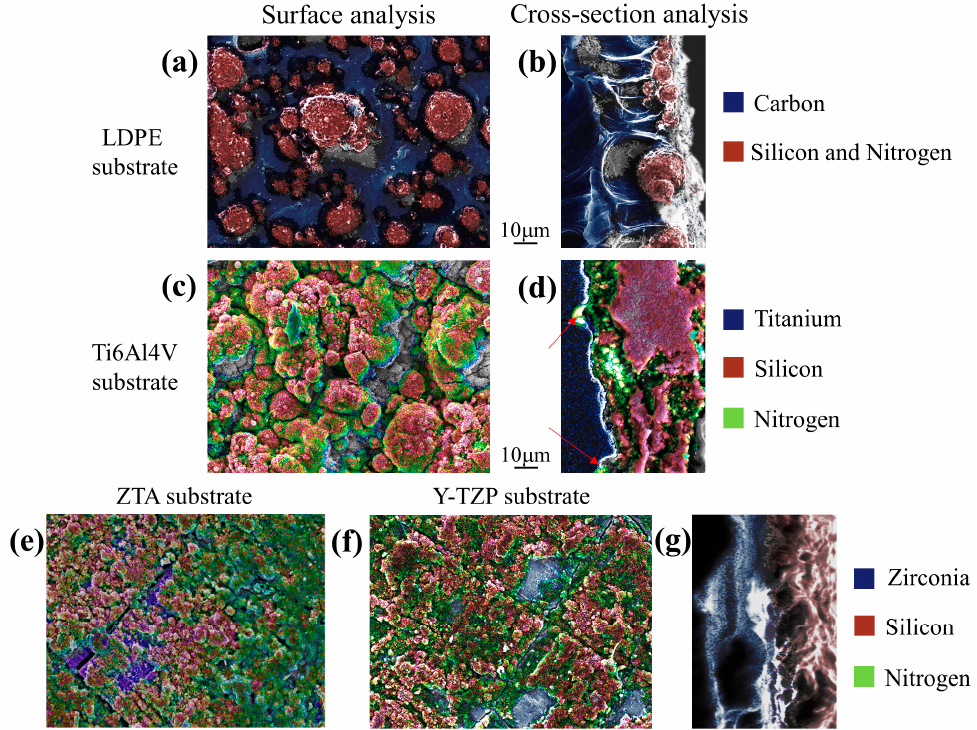
Figure 2. SEM secondary electron images overlapped with EDS compositional maps. LDPE surface analysis ( a ) and cross-section analysis ( b ), Ti6Al4V surface analysis ( c ) and cross-section ( d ), ZTA surface analysis ( e ), Y-TZP surface analysis ( f ), and cross-section analysis ( g ).